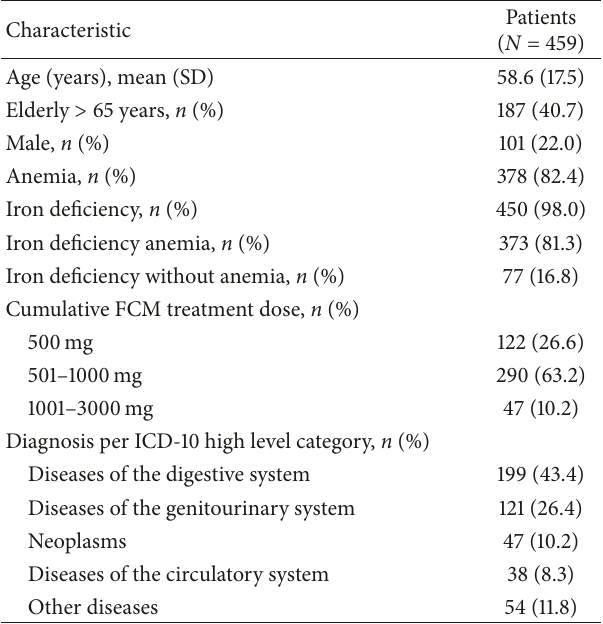
Table 1: Demographic and clinical characteristics of the study